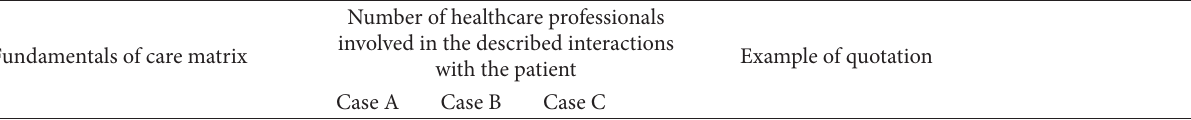
Table 4: The fundamentals of care framework: individual descriptions of care episodes of more positive interactions with staff.